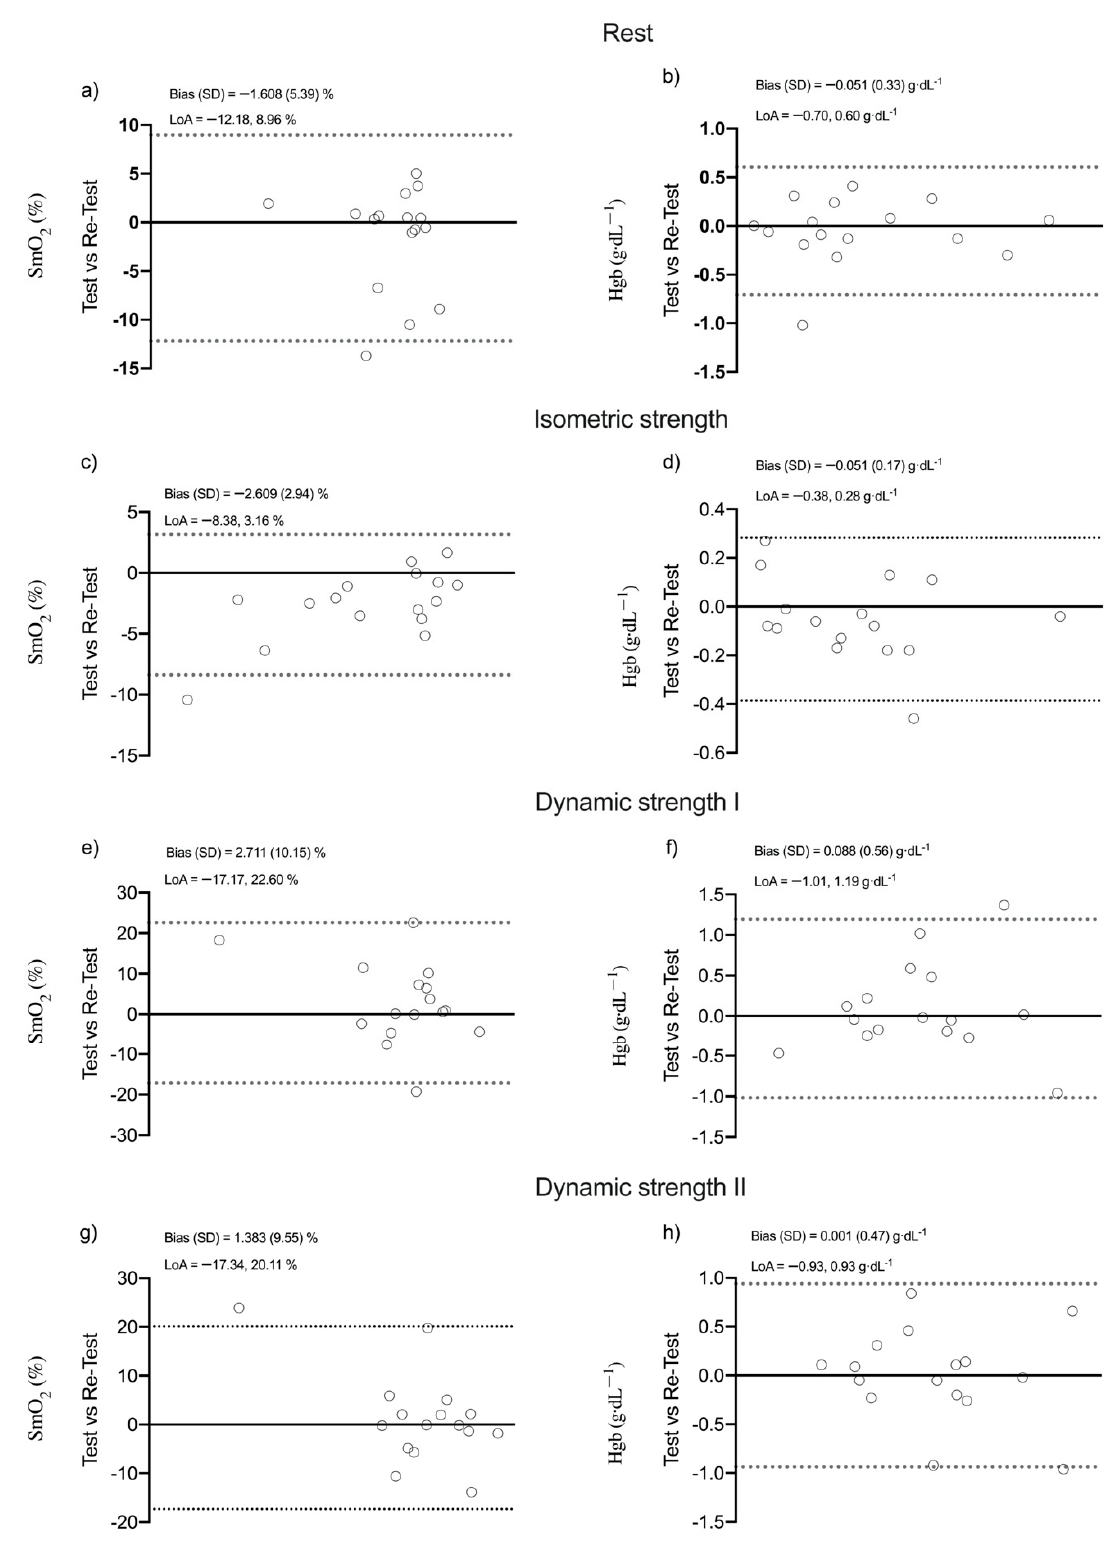
Figure 4. Bland-Altman plots of test-retest for SmO 2 (%) and Hgb (g · dL − 1 ). ( a ) SmO 2 (%) at rest, ( b ) HgB (g · dL − 1 ) at rest, ( c ) SmO 2 (%) at isometric strength ( d ) HgB (g · dL − 1 ) at isometric strength, ( e ) SmO 2 (%) at dynamic strength I, ( f ) HgB (g · dL − 1 ) at dynamic strength I, ( g ) SmO 2 (%) at dynamic strength II, ( h ) HgB (g · dL − 1 ) at dynamic strength II.